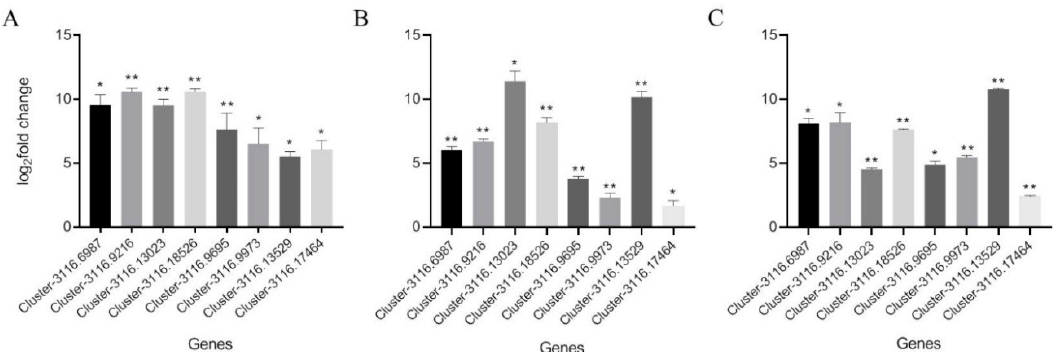
Figure 5. Real-time qPCR results of the eight common upregulated genes, Cluster-3116.6987, Cluster-3116.9216, Cluster-3116.13023, Cluster-3116.18526, Cluster-3116.9695, Cluster-3116.9973, Cluster-3116.13529, Cluster-3116.17464. ( A ) Real-time qPCR results of the above eight common upregulated genes of high-altitude B. pyrosoma in comparison with sequenced low-altitude B. pyrosoma ; ( B ) with low-altitude B. pyrosoma (111°19 ′ 39 ″ E, 37°47 ′ 6 ″ N, altitude 1372 m); ( C ) with low-altitude B. pyrosoma (109°2 ′ 23 ″ E, 33°47 ′ 41 ″ N, altitude 1116 m). The X -axis represents the common upregulated genes in high-altitude B. pyrosoma , the Y -axis represents the values of relative expression levels, * represents p -value < 0.05 and ** represents p -value < 0.01.